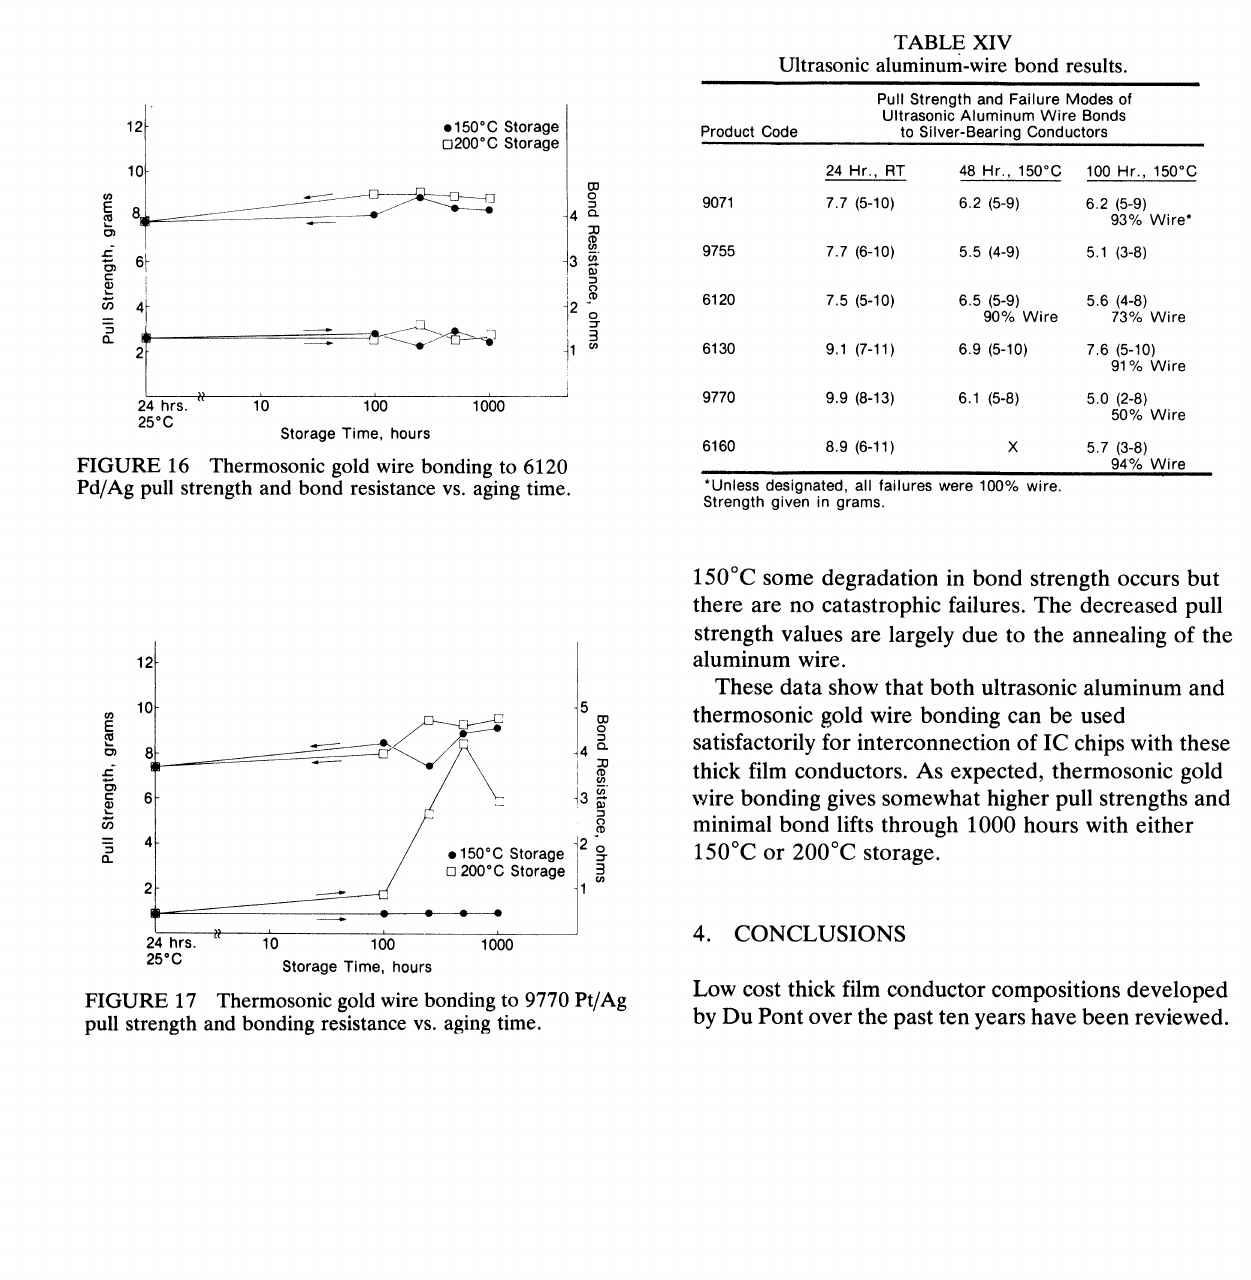
FIGURE 17 Thermosonic gold wire bonding to 9770 Pt/Ag pull strength and bonding resistance vs. aging